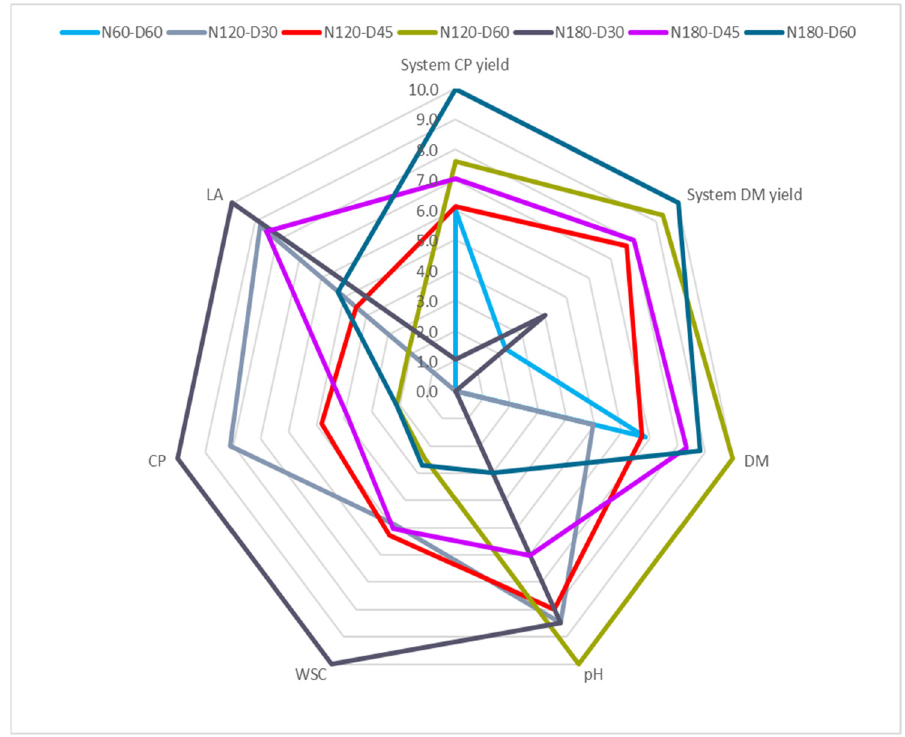
Figure 3. Multicriteria assessment of treatment combinations in alfalfa–silage corn relay intercropping system. A 2-yr system total dry matter (DM) yield, 2-yr system crude protein (CP) yield, and 2-yr average DM content, 2-yr average CP content, 2-yr average pH, 2-yr average lactic acid (LA) concentration and 2-yr average water soluble carbohydrate (WSC) of silage transformed to 0 to 10 scores, 0 being the worst score and 10 the best score. N60, N120 and N180 mean N application rate of 60, 120 and 180 kg N ha − 1 . D30, D45 and D60 mean corn seeding rate of 30, 45 and 60 thousand plants ha − 1